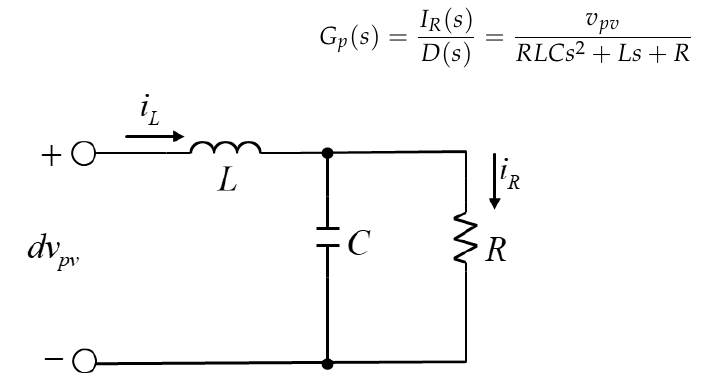
Figure 5. The controlled plant of the current controller.